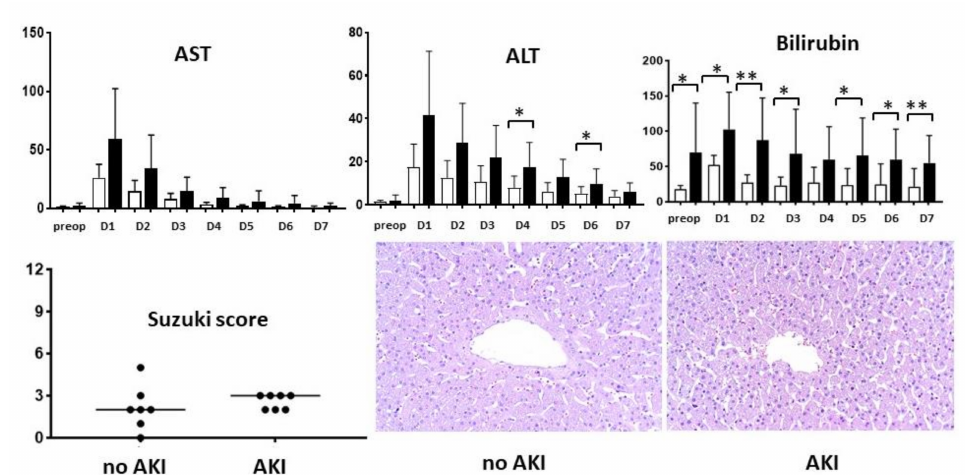
Figure 1. Biochemical and histological assessment of the ischemia–reperfusion injury. Daily liver function tests over the first week in patients without (white bars) and with acute kidney injury (black bars), semiquantitative assessment of the histology (Suzuki score), and representative micropho- tographs (hematoxylin–eosin, original magnification × 200). AKI: acute kidney injury; ALT: alanine aminotransferase; AST: aspartate aminotransferase; D: day. * p < 0.05, ** p <